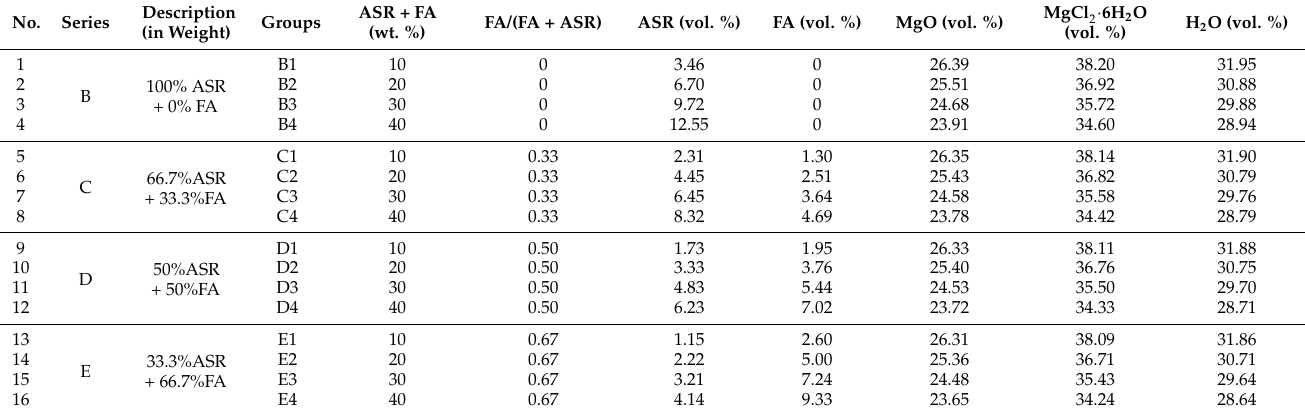
Table 4. Mix proportions of MOC pastes with composite